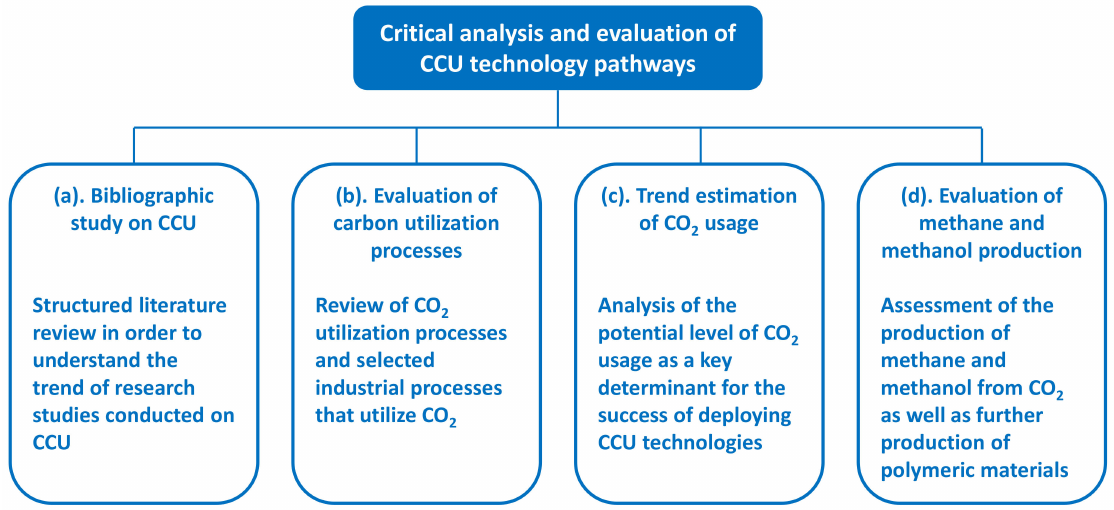
Figure 1. Methodological scheme adopted in the research